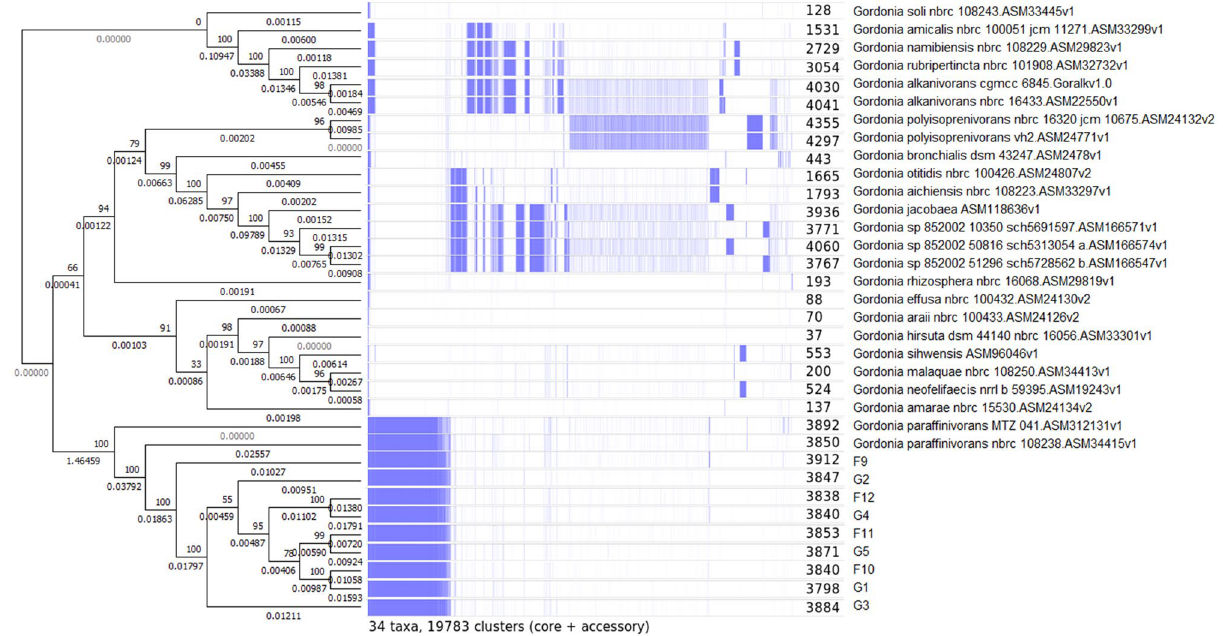
Figure 3. Genetic relationship of Gordonia paraffinivorans mastitis isolates (Field Gordonia paraffinivorans mastitis isolates (n = 9) are marked as F9–F12 and G1–G5. Neighbor-joining tree was constructed on the matrix of presence—absence of genes. Numbers in nodes represents bootstrap values, branch length represent relative genetic distance. In the Roary matrix (middle section), the presence of gene common to at least two genomes is depicted by blue stripe. Number of common genes in genome is shown next to genome identification.) and Gordonia sp . reference genomes.